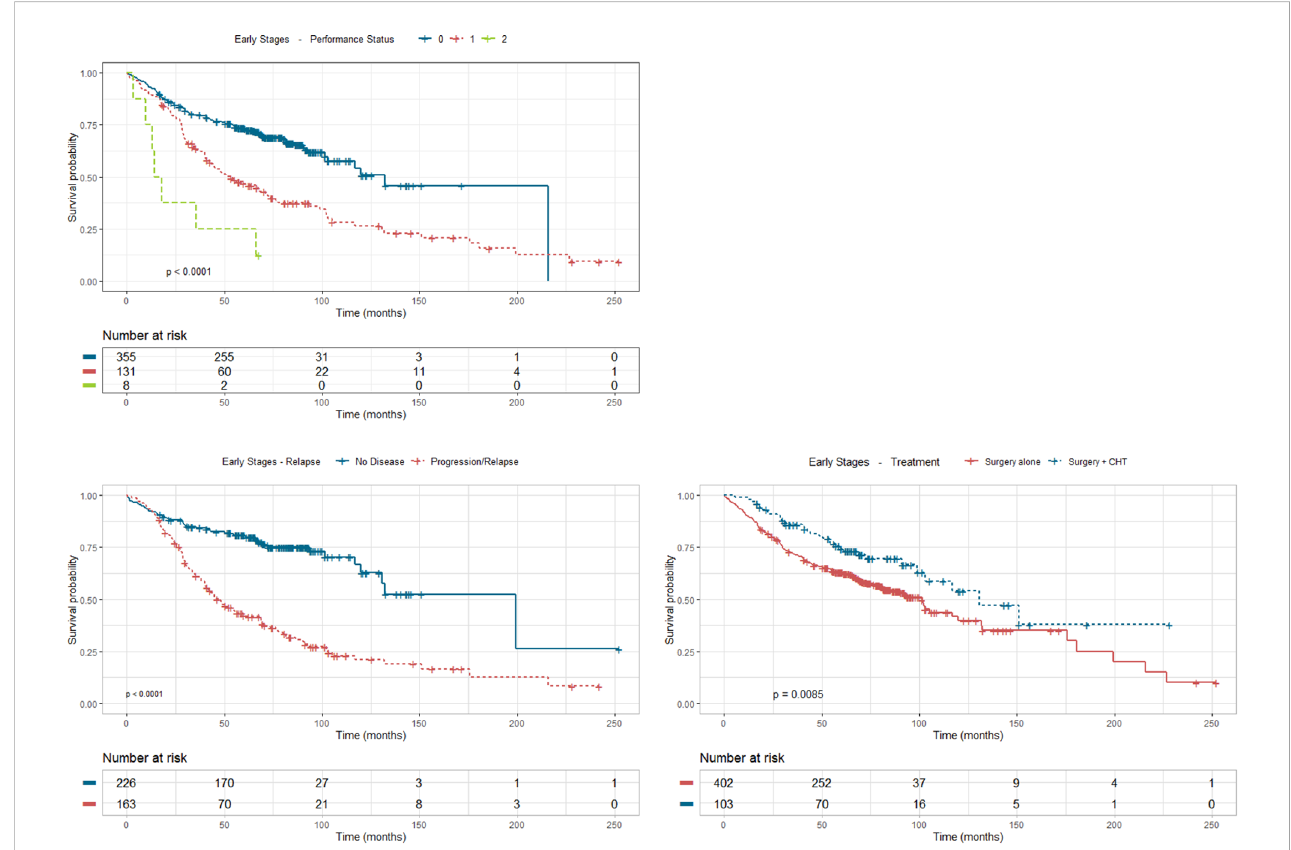
FIGURE 5 Survival analysis using Kaplan Meier estimates in stages I and II according to treatment, performance status and